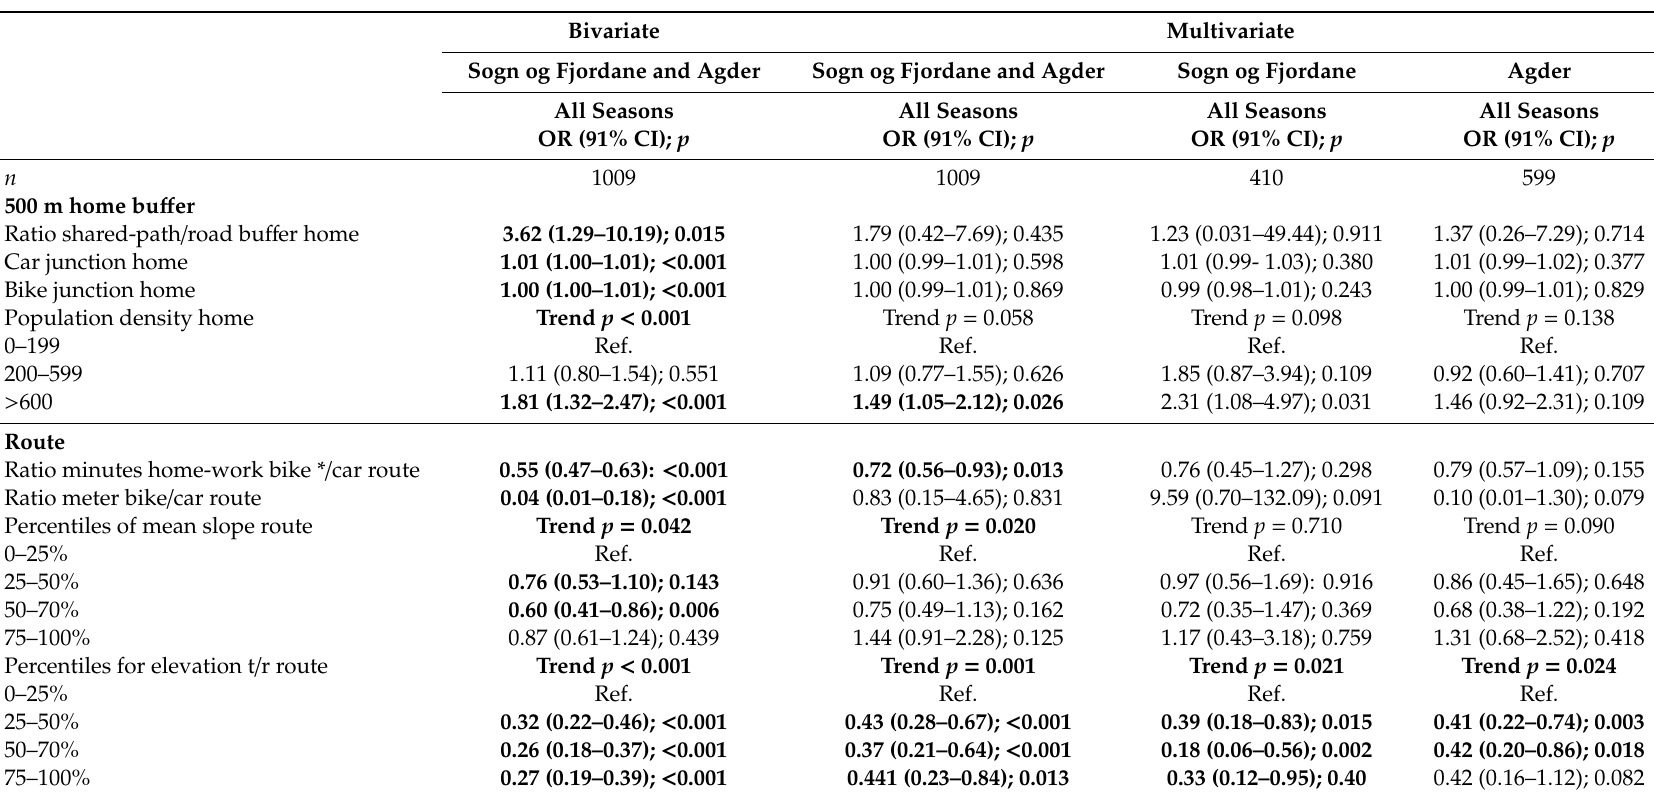
Table A2. Likelihood of being a cyclist. Environmental factors (GIS data). n = 1009. Presented as bivariate and multivariate analyses. Significant associations are written in